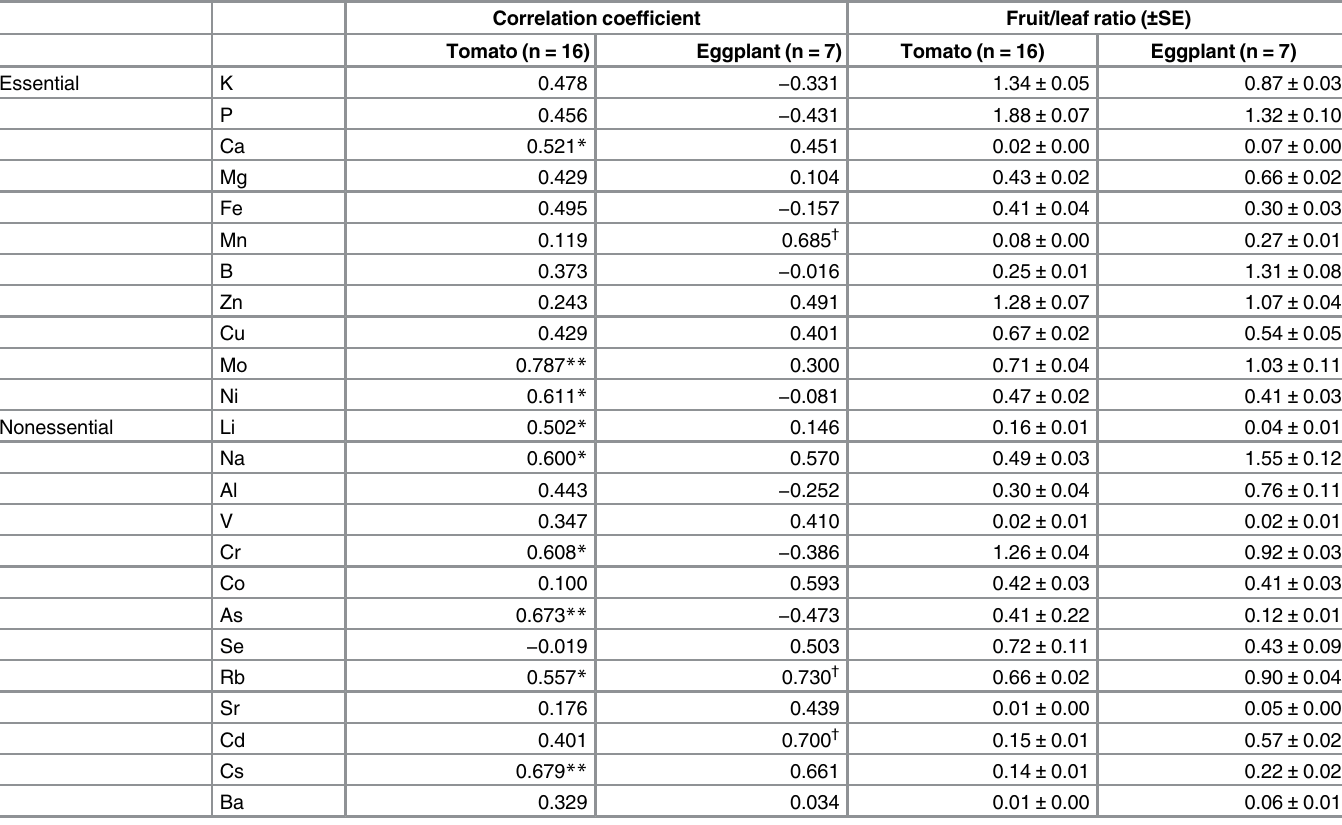
Table 2. Correlation coefficients and ratio of the concentrations of each element in the leaves and fruit of different cultivars of tomato and